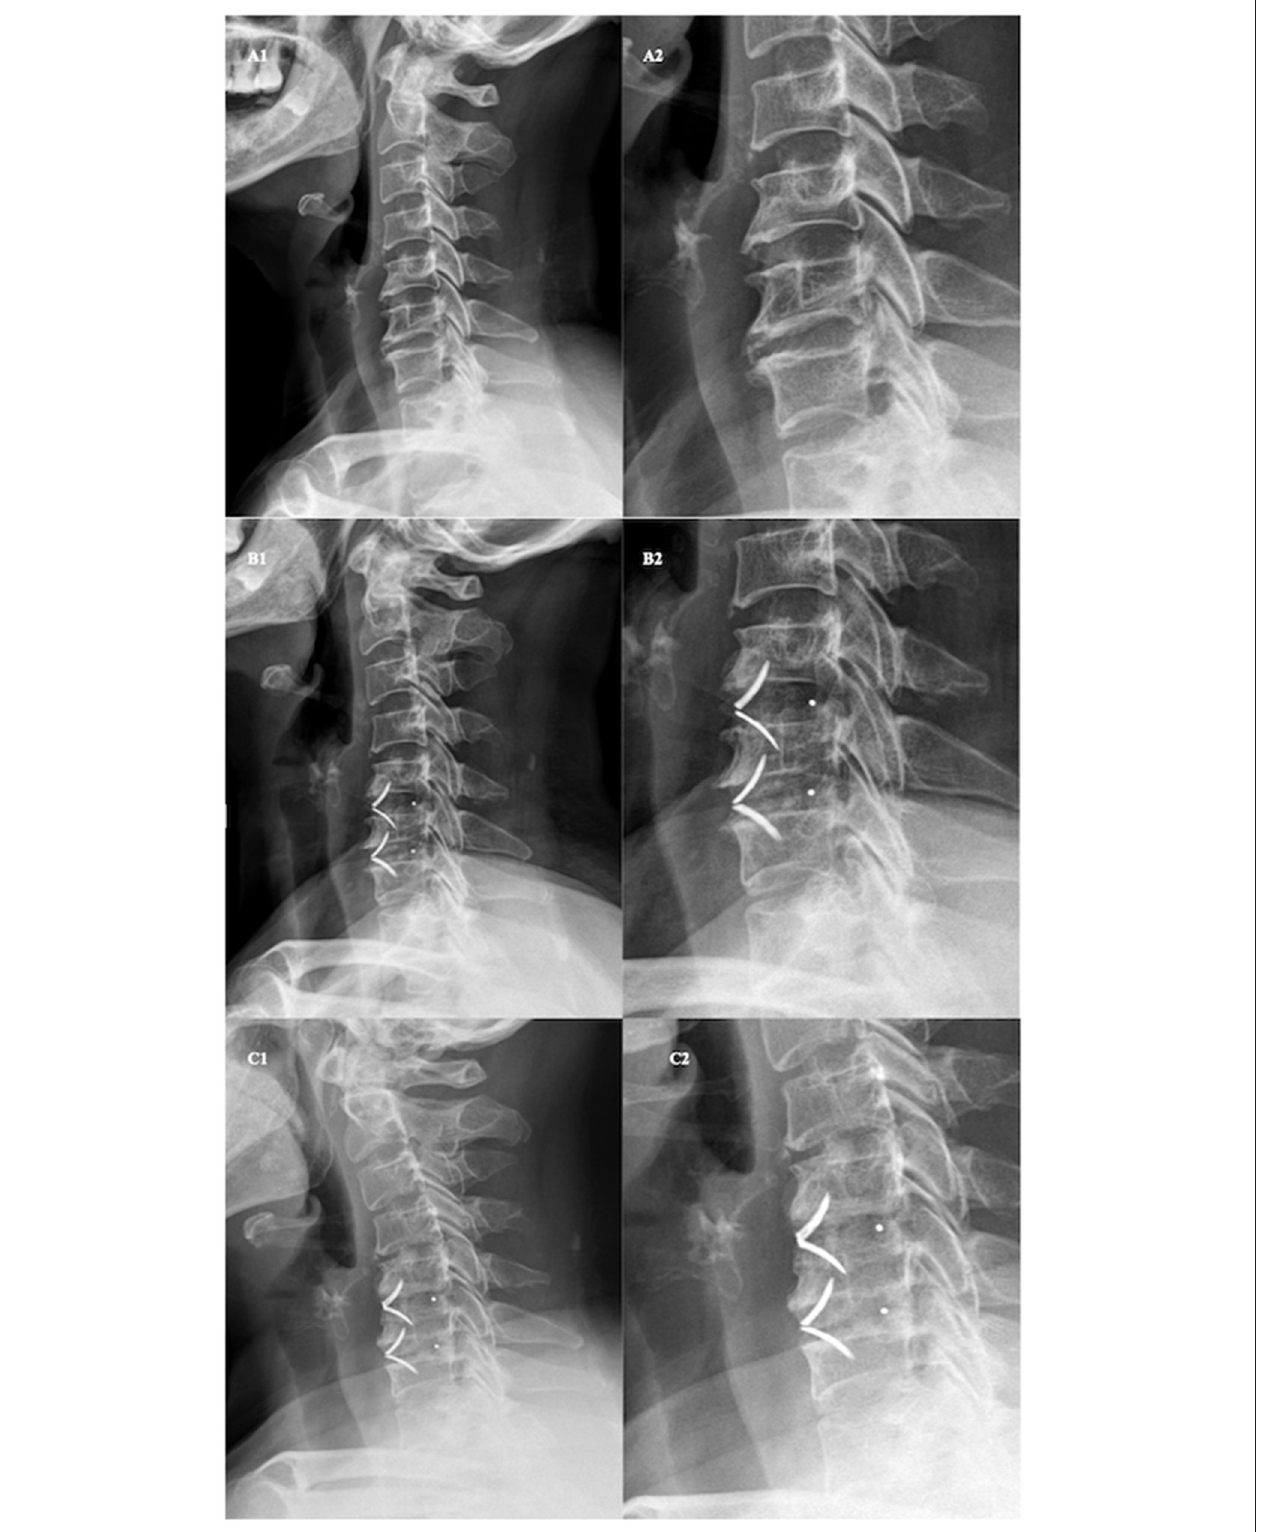
FIGURE 4 | Demonstration of cage subsidence after ACDF and its influence on local and general cervical lordosis. Lateral radiograph (A1) and enhanced view (A2) before anterior cervical discectomy and fusion with ROI-C cage. Lateral radiograph (B1) and enhanced view (B2) one month after ACDF with ROI-C cage. Lateral radiograph (C1) and enhanced view (C2) one year after ACDF with ROI-C cage. Fused segment cobb angle were 0 ◦ , 10 ◦ , and, 0 ◦ and Cervical cobb angle were 2 ◦ , 5 ◦ , and − 15 ◦ before operation, 1-month post-op, and 1-year post-op respectively.